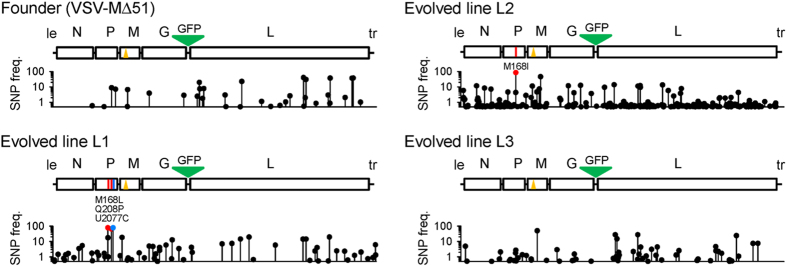
Sequence changes following evolution of VSV-MΔ51 in MRC-5 cells.For each virus (founder, L1–L3), a genome map is shown with the five VSV genes (N, P, M, G, L) indicated in boxes. The leader (le) and trailer (tr) regions were also sequenced by the Sanger method. The MΔ51 virus contained a GFP gene inserted between G and L. Mutations detected by Sanger sequencing are indicated with colored vertical lines (red: non-synonymous, blue: synonymous/non-coding). The original Δ51 deletion is indicated with a yellow triangle and was preserved in all evolved lines. The scatter plots represent the frequency (0.5–100% range) of single-nucleotide polymorphisms as determined by Illumina ultra-deep sequencing. Changes detected by the Sanger method are represented as colored dots. A list of all SNPs detected by Illumina sequencing is provided in Supplementary Data S1.